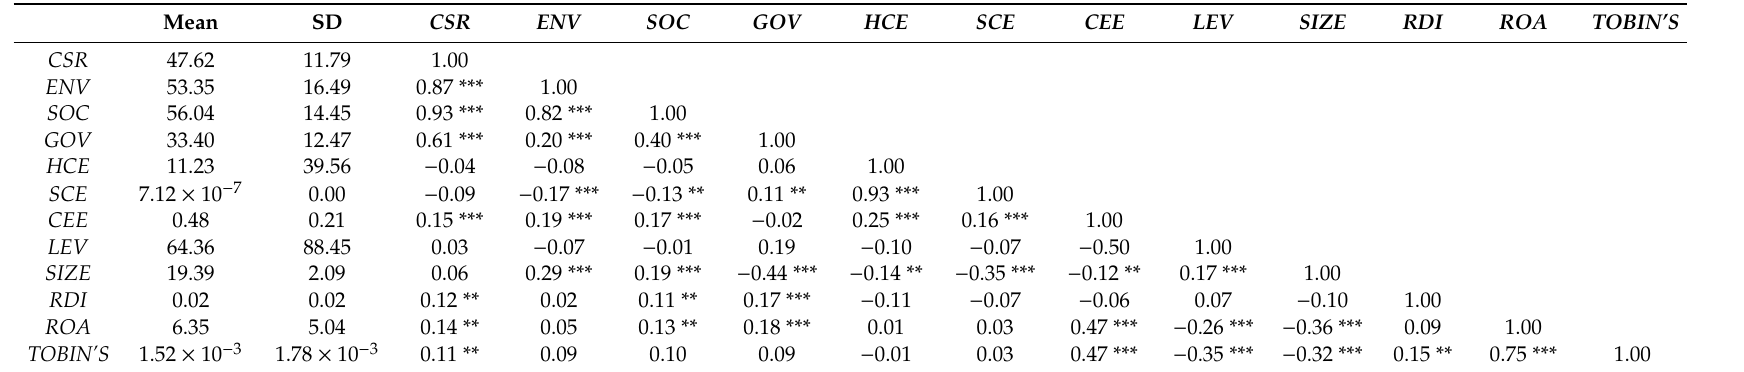
Table 1. Correlation matrix, means, and standard